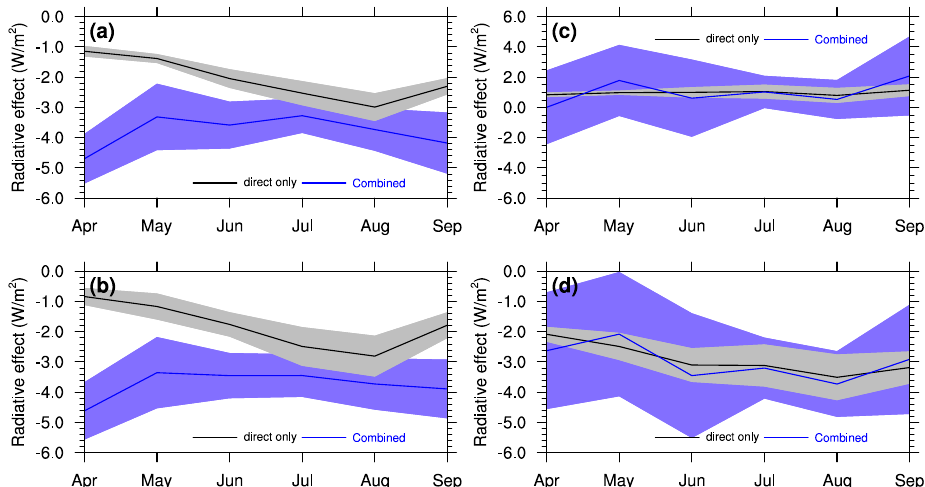
Fig. 6. (a) 18-yr monthly area-mean sulphate radiative effect (Control minus SO 2 1950) at TOA over East Asia (20–45 ◦ N, 100–122 ◦ E). (b) Same as (a) , but for surface. (c) 18-yr monthly area-mean black carbon radiative effect (Control minus SO 2 1950) at TOA over East Asia. (d) Same as (c) , but for surface. Units: Wm − 2 . Black line is direct-only effect, grey shading is standard deviation. Blue line is combined effect, blue shading is standard deviation.